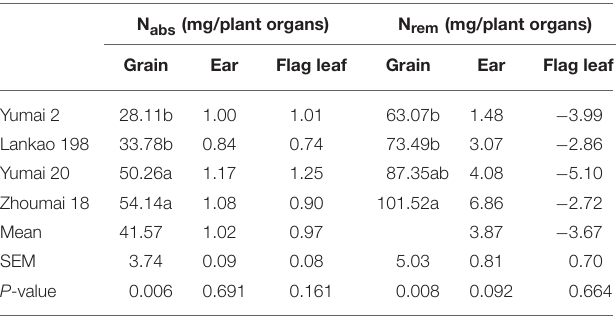
TABLE 3 | The mean, standard error of the mean (SEM) and the P -value for the ONE-WAY ANOVA test for the whole ear and flag leaf blade nitrogen absorption (N abs ) from anthesis to 2 weeks after anthesis, and nitrogen remobilization (N rem ) during the same period in four Chinese winter wheat genotypes. N abs (mg/plant organs)